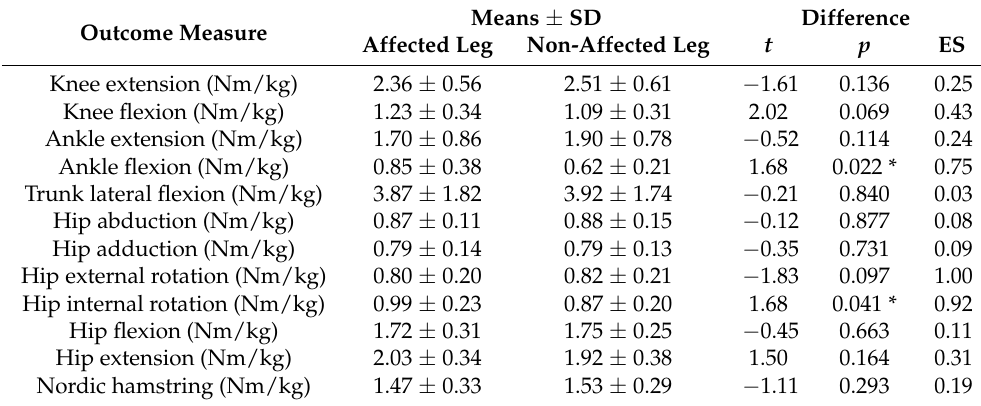
Table 3. Affected and non-affected leg strength outcome measures within participants with unilat- eral